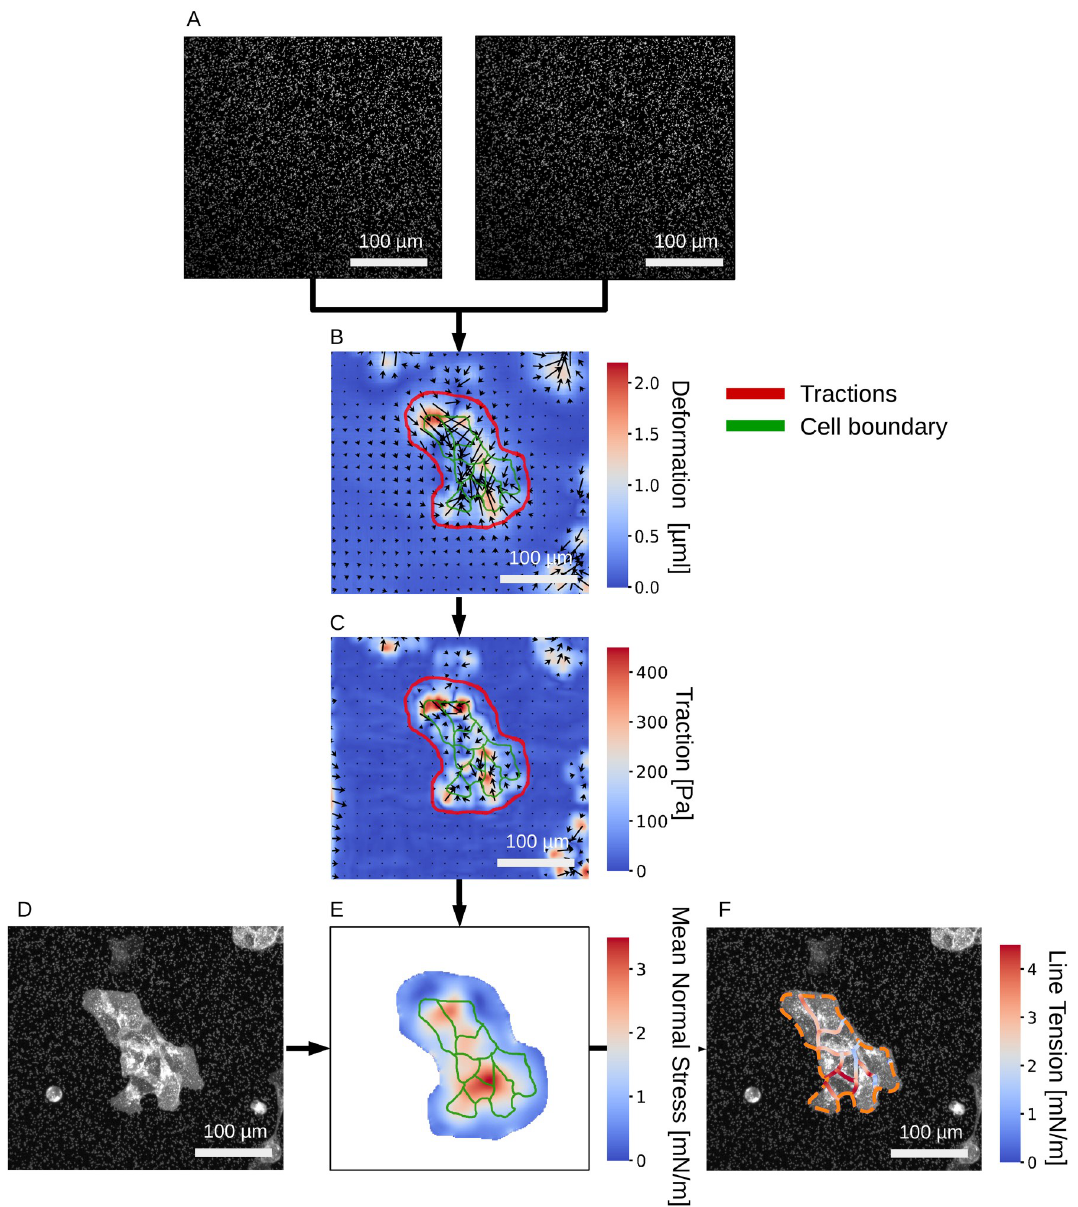
Fig 5. Analysis of stress and force generation of a MDCK cell colony. A: Images of substrate-embedded fluorescent beads before and after the cells are detached by trypsinization. B: Substrate deformation field. C: Traction field. The user selects the area (red outline) over which contractility, strain energy and cell stresses are subsequently calculated. D: Image of the cell colony; fluorescent membrane staining with tdTomato-Farnesyl. E: Absolute value of the Mean normal stress in the cell colony. F: Line tension along cell- cell borders. The orange dashed line marks the outer edge of the cell